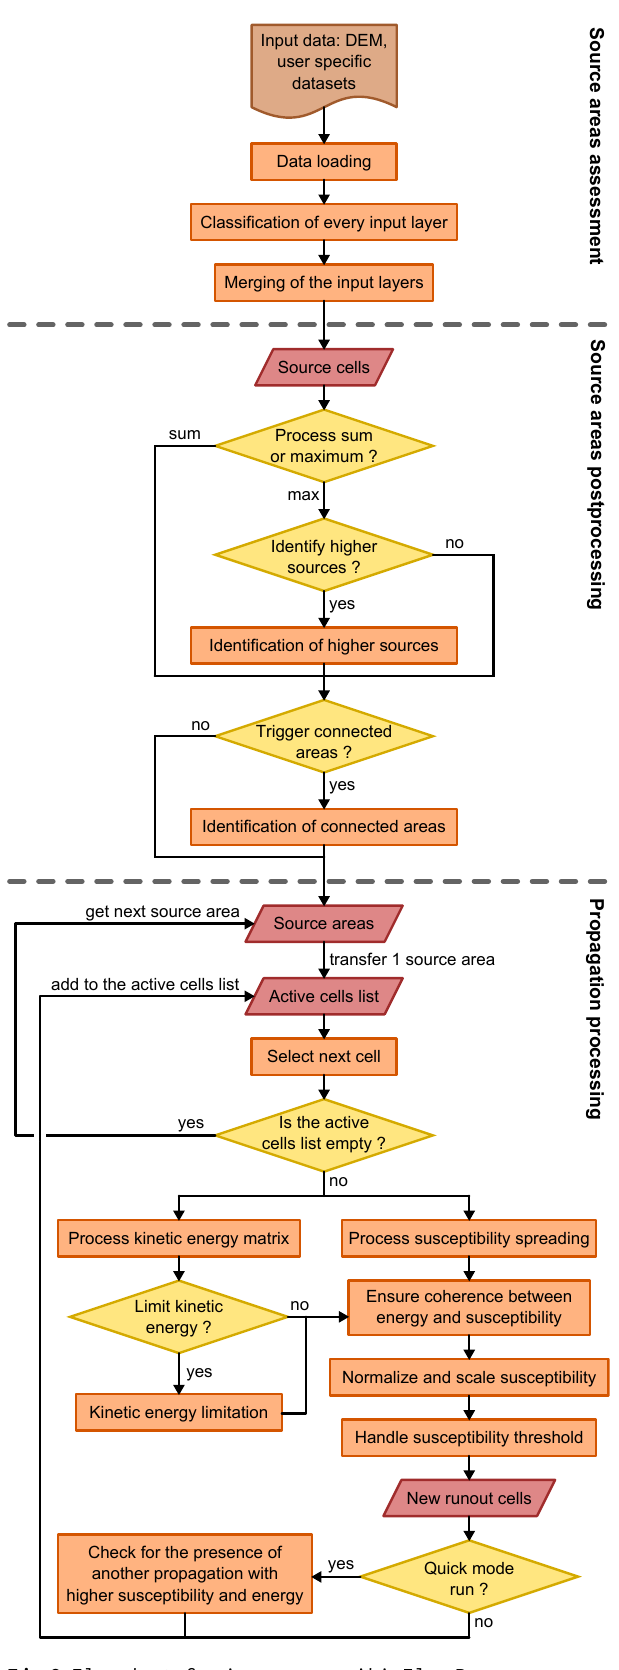
Fig. 6. Flow chart of main processes within